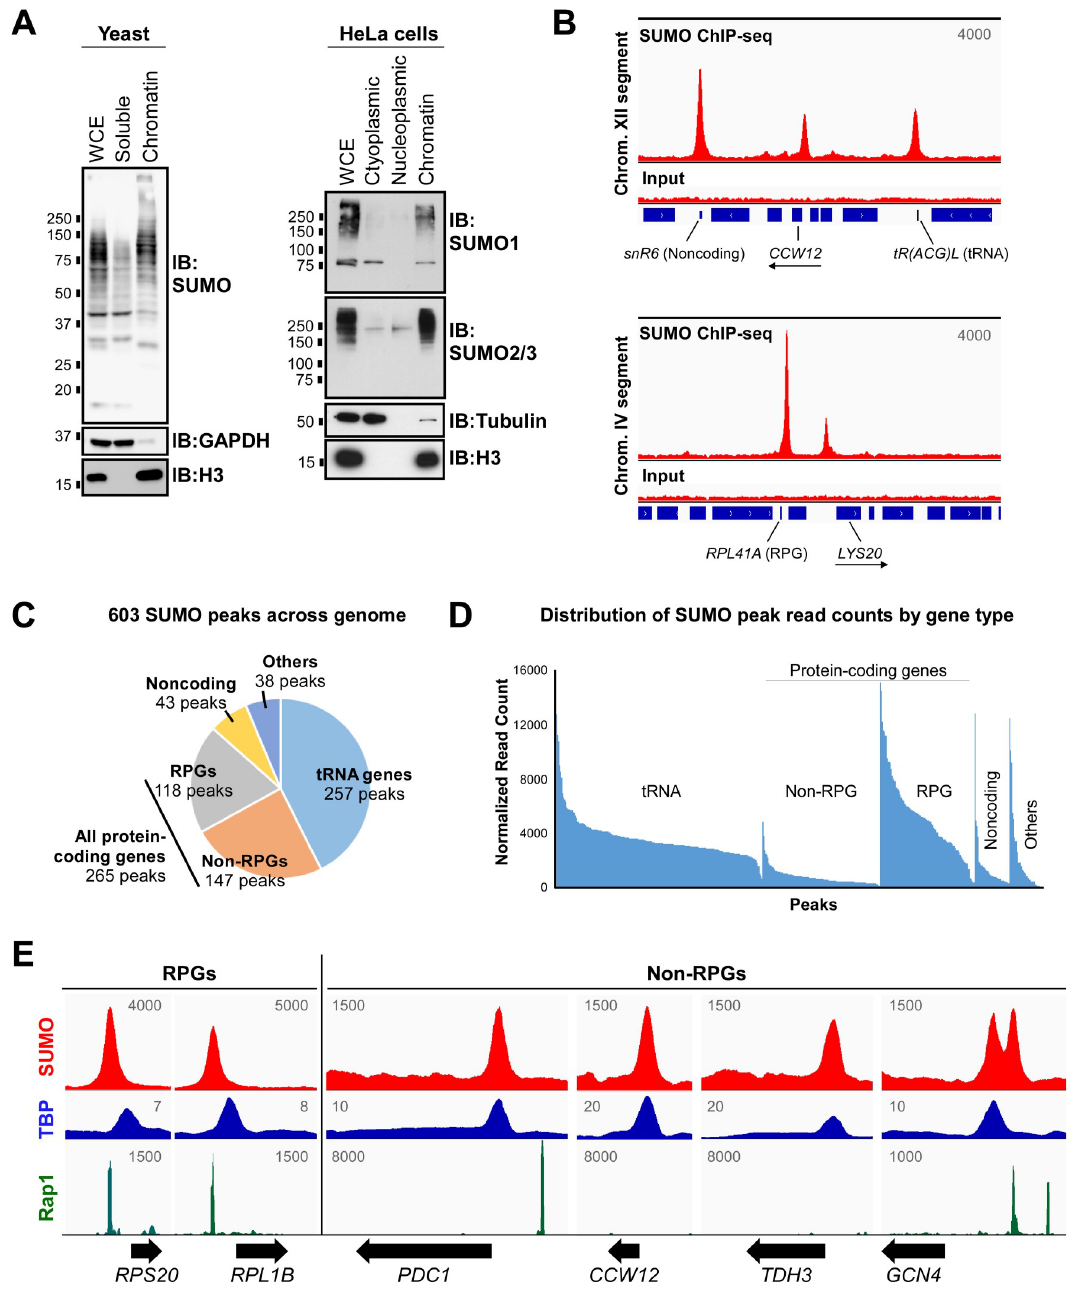
Fig 1. Sumoylated proteins associate stably with chromatin, including at many non-RPGs. (A) Most sumoylated proteins are associated with chromatin. Fractionation experiments were carried out in normally growing, unmodified yeast and human HeLa cells, then whole cell extracts (WCE) and indicated fractions were analyzed by immunoblot (IB) with indicated antibodies, including antibodies for the yeast Smt3 peptide (“SUMO”), human SUMO1 or SUMO2/3 isoforms, and histone H3. (B) Independent duplicate SUMO ChIP-seq experiments were performed in yeast, and sample alignments are shown from Replicate 1, using the Integrative Genomics Viewer (IGV) genomic alignment tool, with reads from the SUMO IP and corresponding inputs over selected short segments of Chromosomes XII and IV. Values correspond to maximum data range (read numbers) for the view shown and blue bars along the bottom represent gene positions, including for two non-RPGs, CCW12 and LYS20 , whose ORF orientations are indicated with arrows. See S9 Table for a list of yeast genes associated with the 603 SUMO peaks. (C) Pie chart showing fractions of the 603 SUMO ChIP-seq peak set associated with different gene types. Non-RPG refers to protein-coding genes that are not ribosomal protein genes (RPGs). See S2 Table for detailed description of peak classifications. (D ) Distribution of read counts for the 603 SUMO ChIP-seq peaks, separated by gene type, then ranked by normalized read counts. Normalized read counts were determined